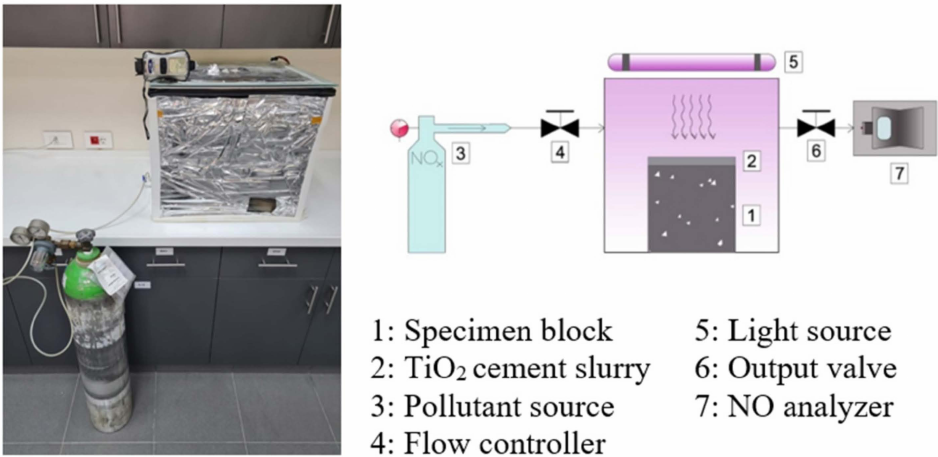
Figure 3. Schematic illustration of the photocatalytic test